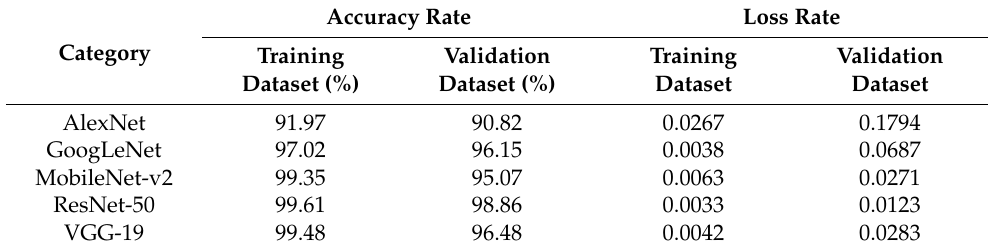
Table 3. Classification accuracy and loss of each